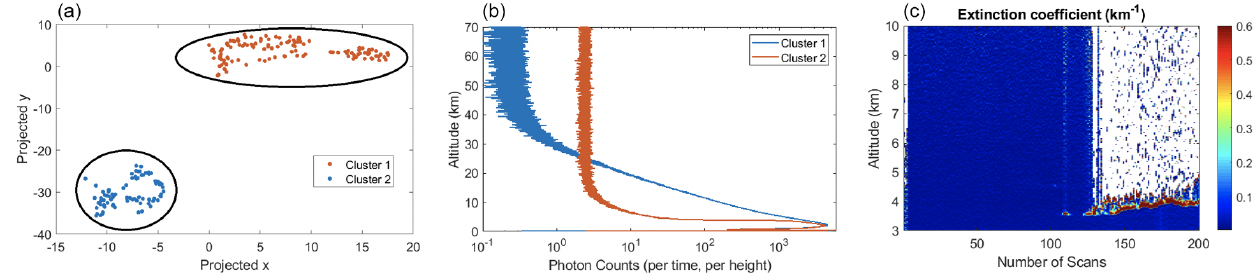
Figure 6. (a) Profiles for the nitrogen channel on the night of 15 May 2012 were clustered into two different groups using the t -SNE algorithm. (b) The red line (cluster 2) is the average of all signals within this cluster and indicates the profiles in which clouds are detectable. The blue line (cluster 2) is the average of all signals within this cluster and indicates the clear profiles (non-cloudy condition). (c) The particle extinction profile for the night shows the last 70 profiles are affected by thick clouds at about 4.5km